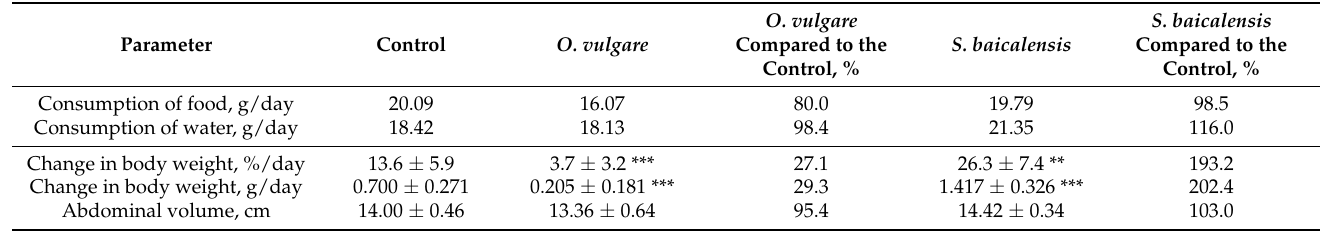
Table 1. Changes in the body weight and fodder consumption of young male rats under the impacts of the addition of Origanum vulgare L. and Scutellaria baicalensis Georgi to their rations (x ± SD, n = 8, duration of experiment—30 days).